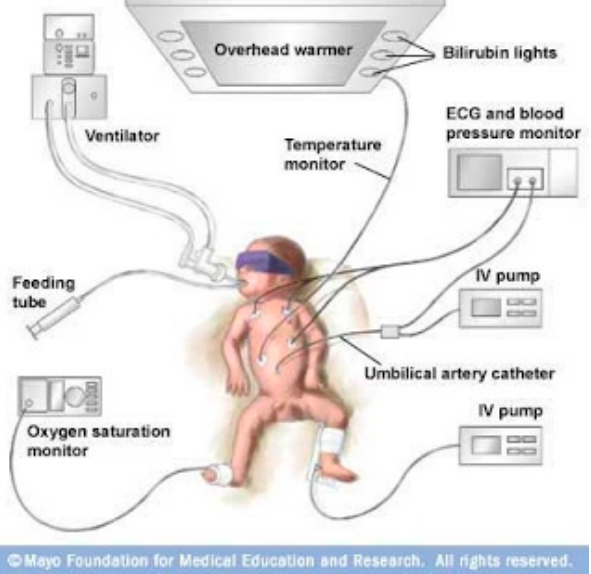
Figure 1. Schematic of NICU support for neonate (used with permission of Mayo Foundation for Medical Education and Research, all rights reserved).